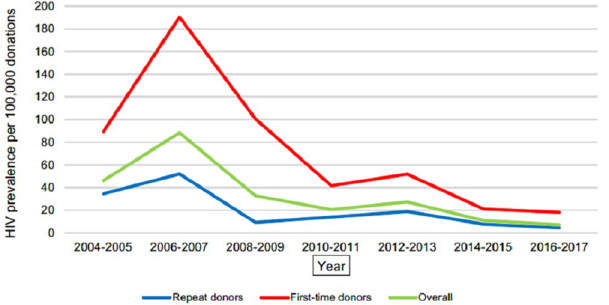
Fig 1. HIV prevalence per 100,000 donations. Annual trends of HIV prevalence per 100,000 donations in the National Blood Center of Lithuania from 2005 to